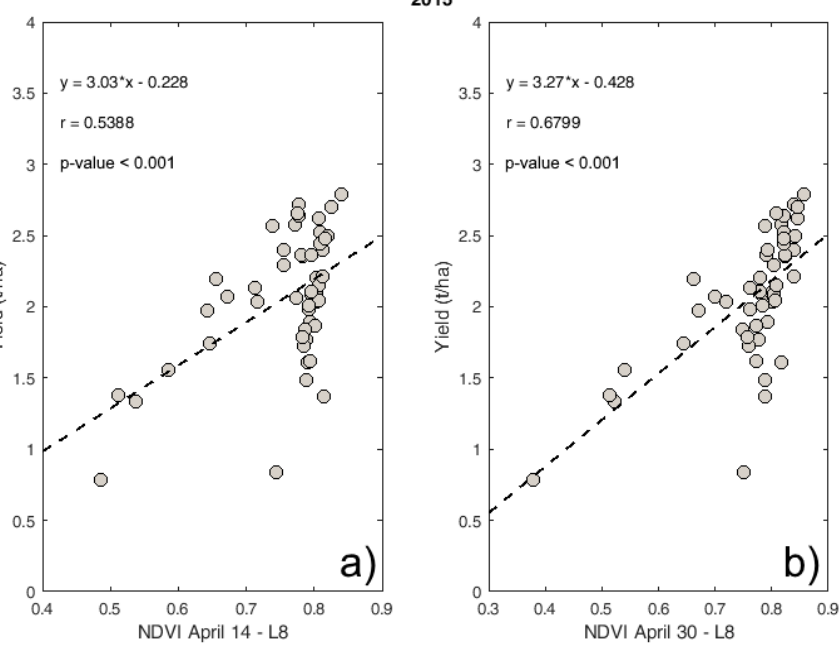
Figure 5. Relationship between observed yield (yield monitor) and NDVI (Landsat-8) for 2014–2015 crop season in ( a ) 14 April and ( b ) 30 April.